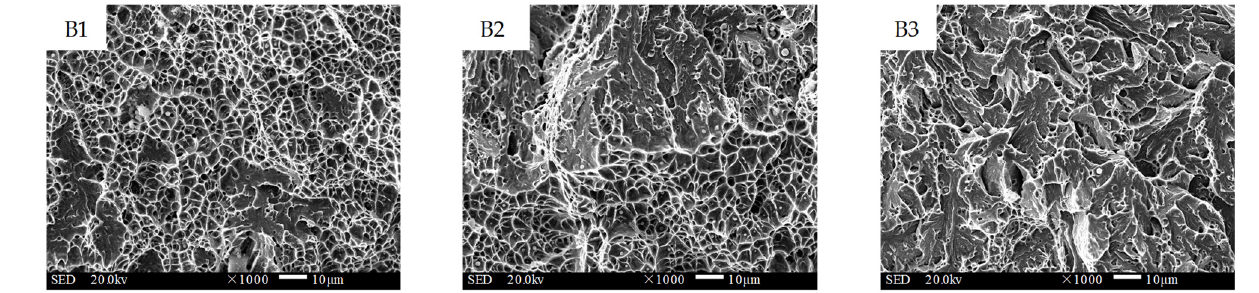
Figure 14. Impact fracture morphology of interface B between the transition and the intermediate layer (1000×).